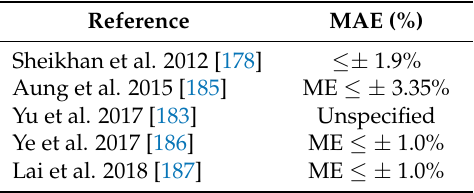
Table 17. MAE/ME of the PSO, variants of the PSO and hybrid PSO-based SOC estimation method.